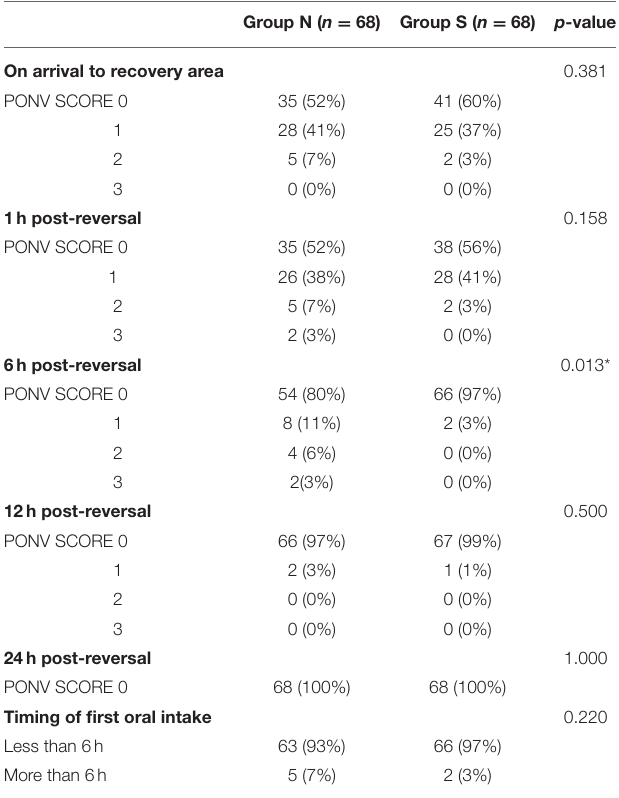
TABLE 2 | Incidence and severity of PONV in groups. Data presented as number